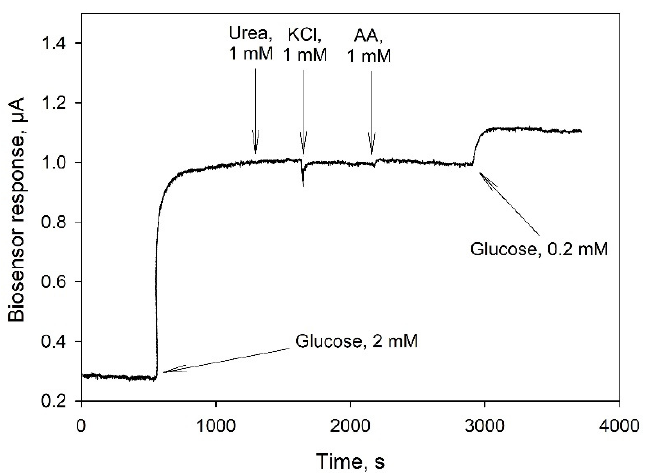
Figure 6. Amperometric response of a TEG/PEDOT:PSS/PEGDE biosensor to the addition of glucose and some interferents at a potential of 0.4 V (vs Ag/AgCl).